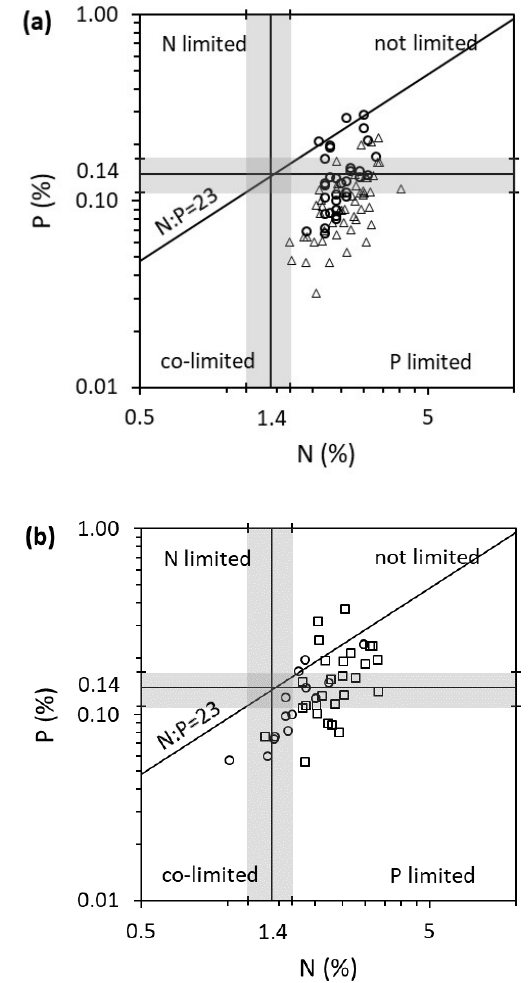
Figure 2. Tissue nutrient concentrations (% dry weight) from the shoots of Juncus bulbosus in ( a ) six lakes ( n = 86) surveyed in spring (circles) and autumn (triangles) 2006 and ( b ) 16 lakes (circles) and 28 river sites (squares) surveyed in summer 2010. Results plotted against average ( ± standard error of the mean, grey shade) nutrient N (1.4 ± 0.25), P (0.14 ± 0.03) and N:P (23.4 ± 3.3) critical thresh- olds for maximum yield determined for hydrophytes from a literature review of laboratory assays [26].